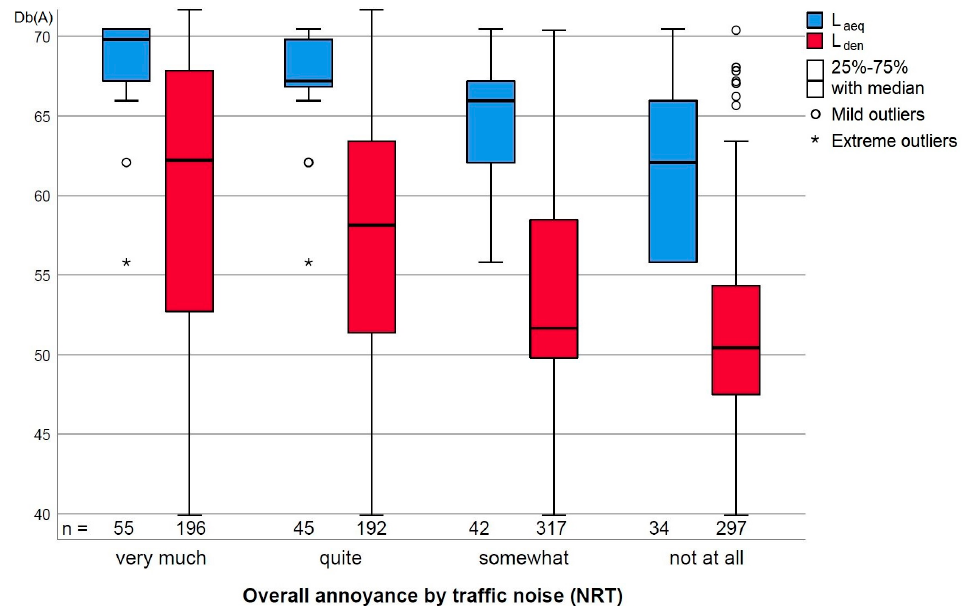
Figure 7. Distributions for L den and L aeq in relation to traffic noise NRT.